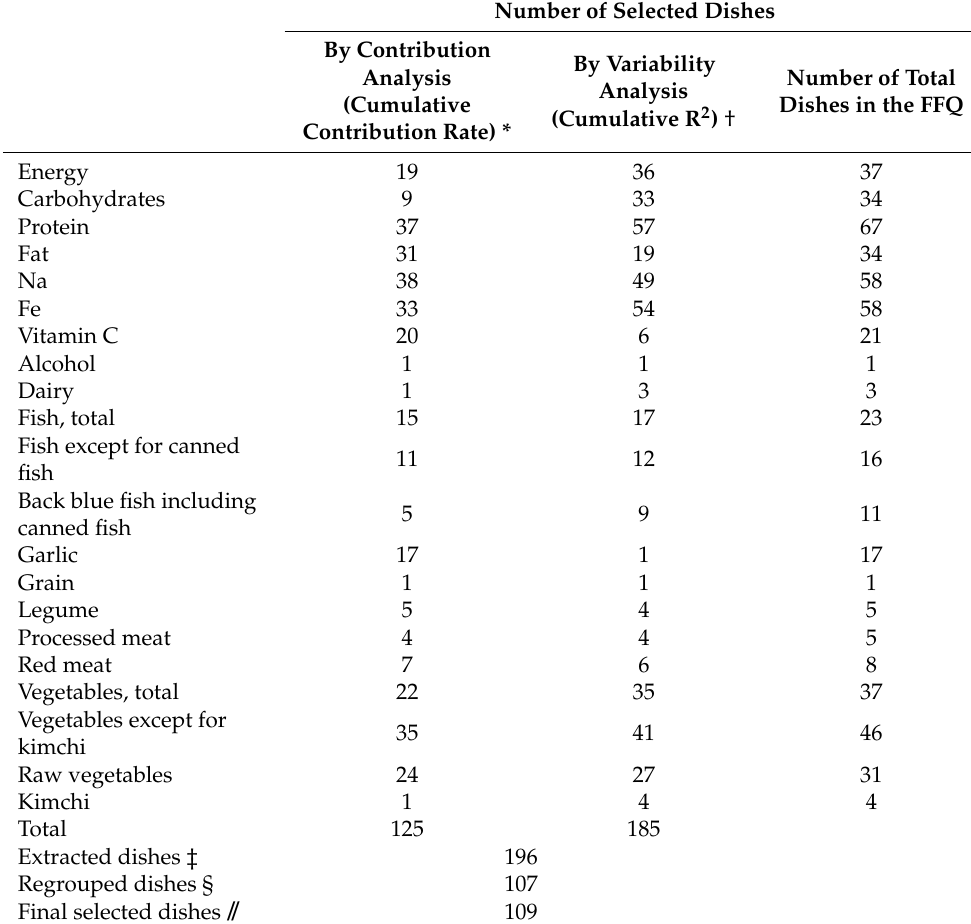
Table 2. Number of selected dishes through contribution analysis and variability analysis.